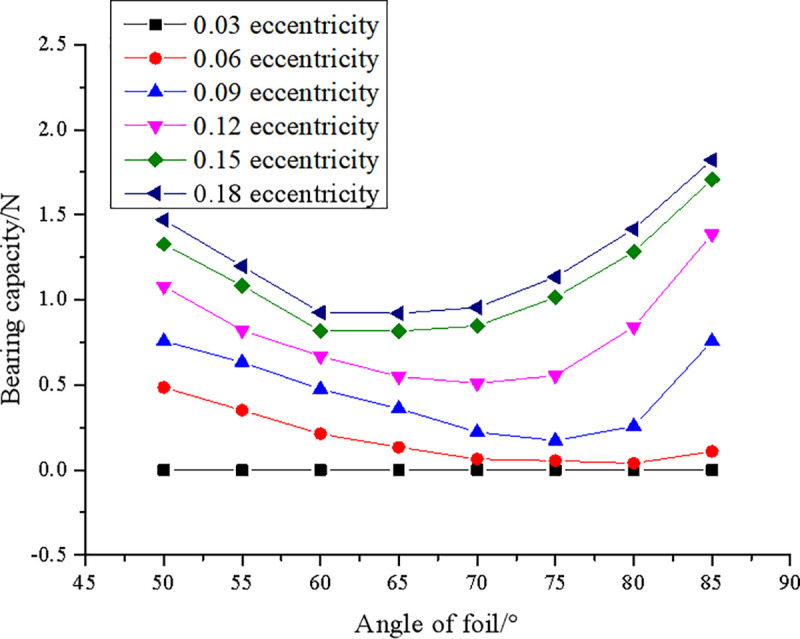
The influence of the spread angle of the foil on the bearing capacity under different eccentricities.